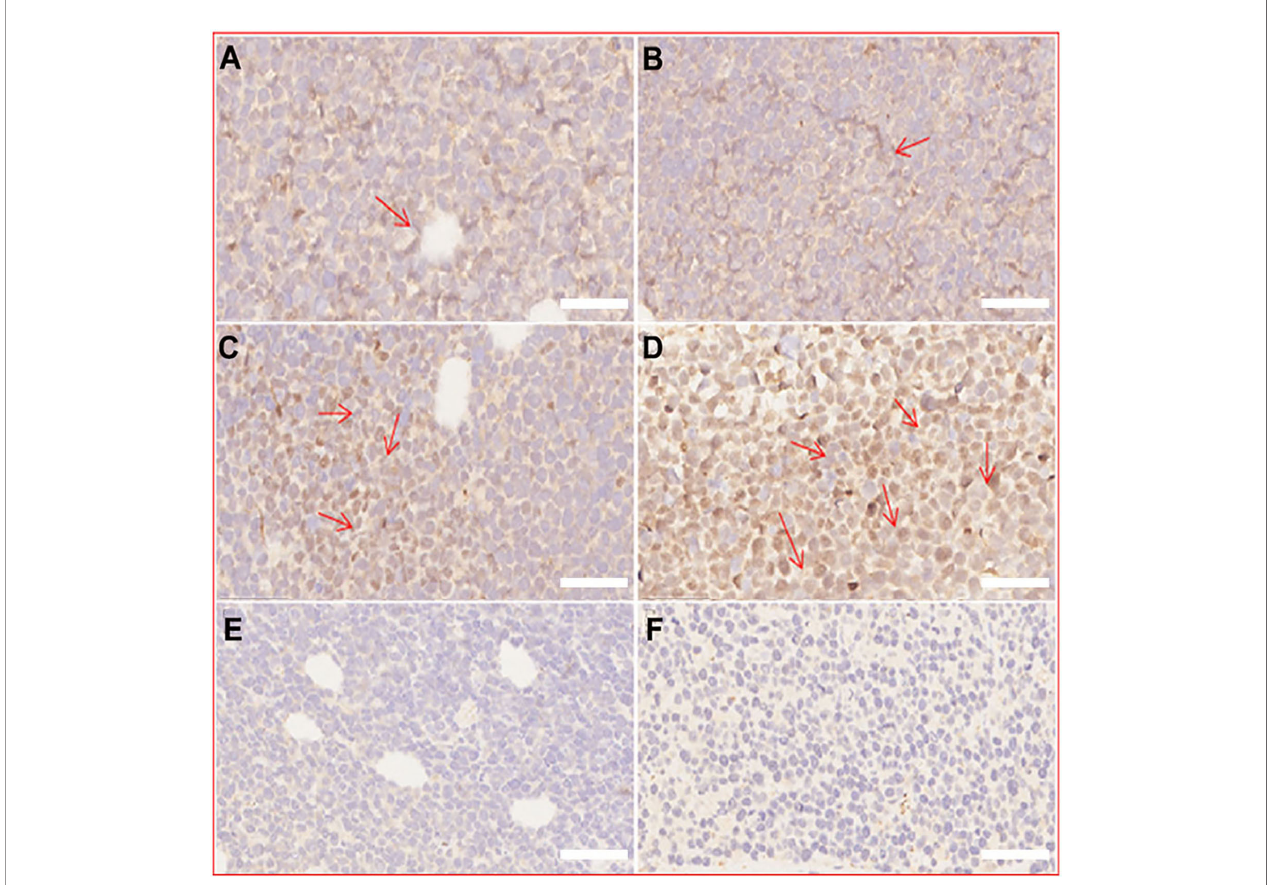
FIGURE 7 | Immunohistochemical staining of HIF- a . (A) normal saline, (B) ENPs, (C) NPs plus PDT, (D) ENPs plus PDT, (E) CNPs plus PDT, (F) CENPs plus PDT. (scale bars 50 m